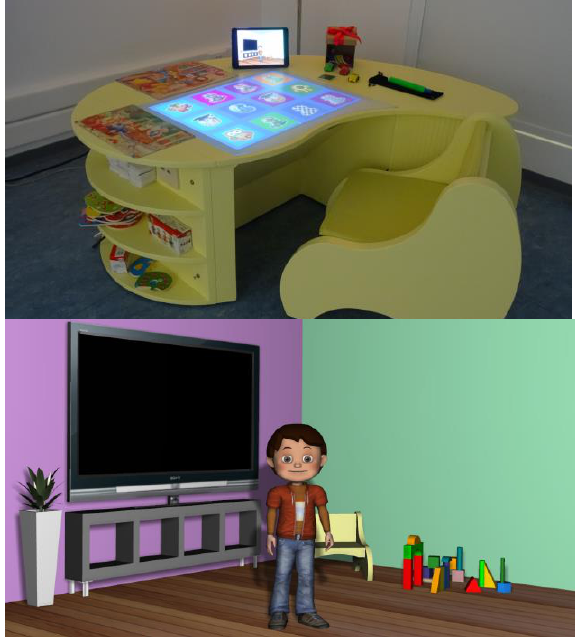
Figure 1. Beantable: An augmented interactive table (Up), Max: Cross-platform three-dimensional avatar (Down)